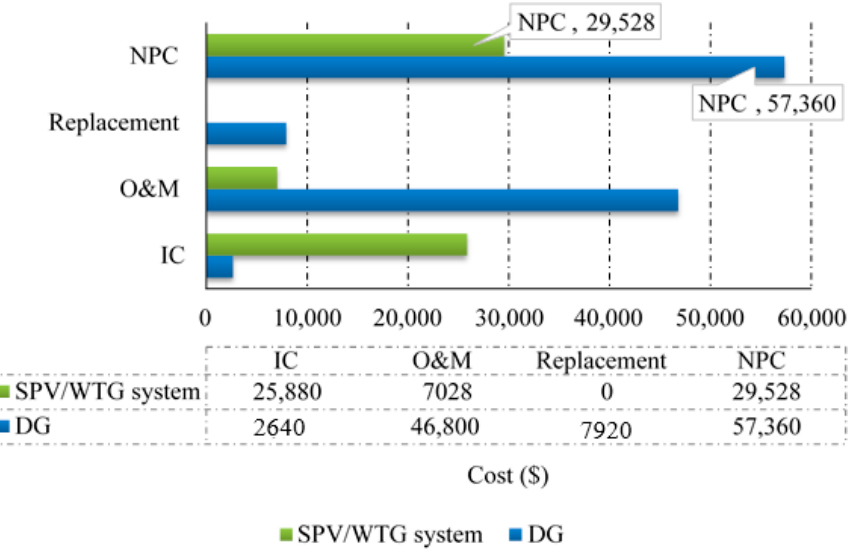
Figure 21. Summary an OPEX of the SPV/WTG system vs. DG over the project lifetime.